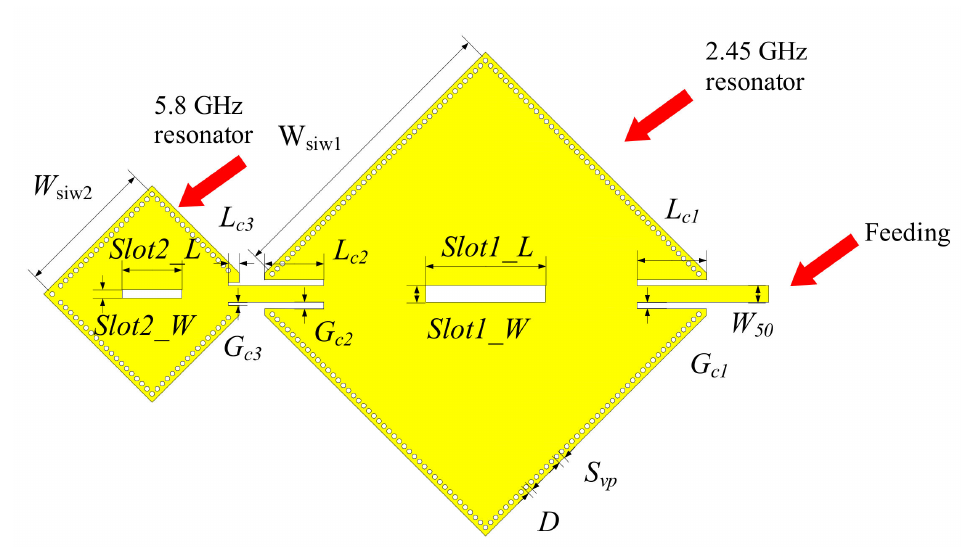
Figure 1. Structure of the SIW resonators.